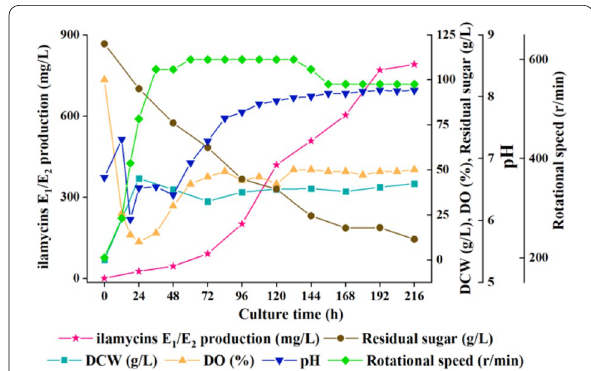
Fig. 11 Time courses of ilamycins E 1 /E 2 production, pH values, DCW, dissolved oxygen (DO), rotational speed and residual sugar with addition of ZnCl 2 in a 5-L